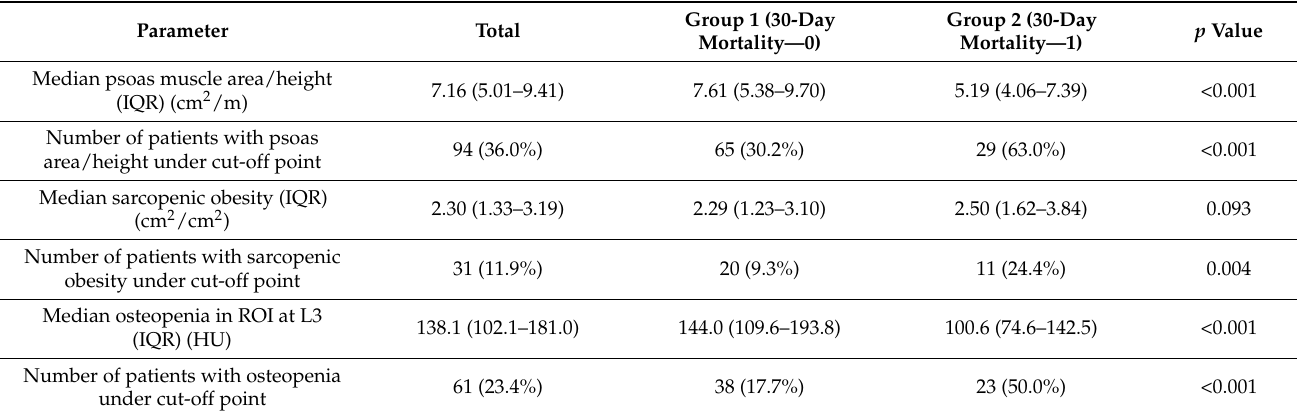
Table 4. Radiological frailty parameters in study